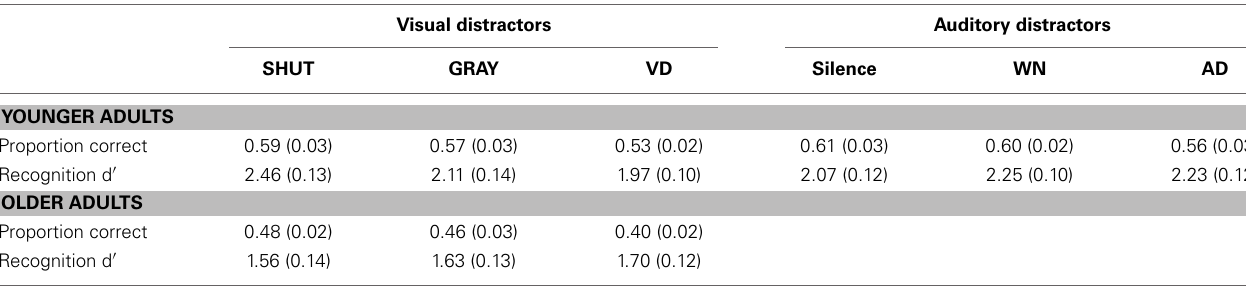
Table 1 | Behavioral results for groups of younger and older adults. Visual distractors Auditory distractors SHUT GRAY VD Silence WN